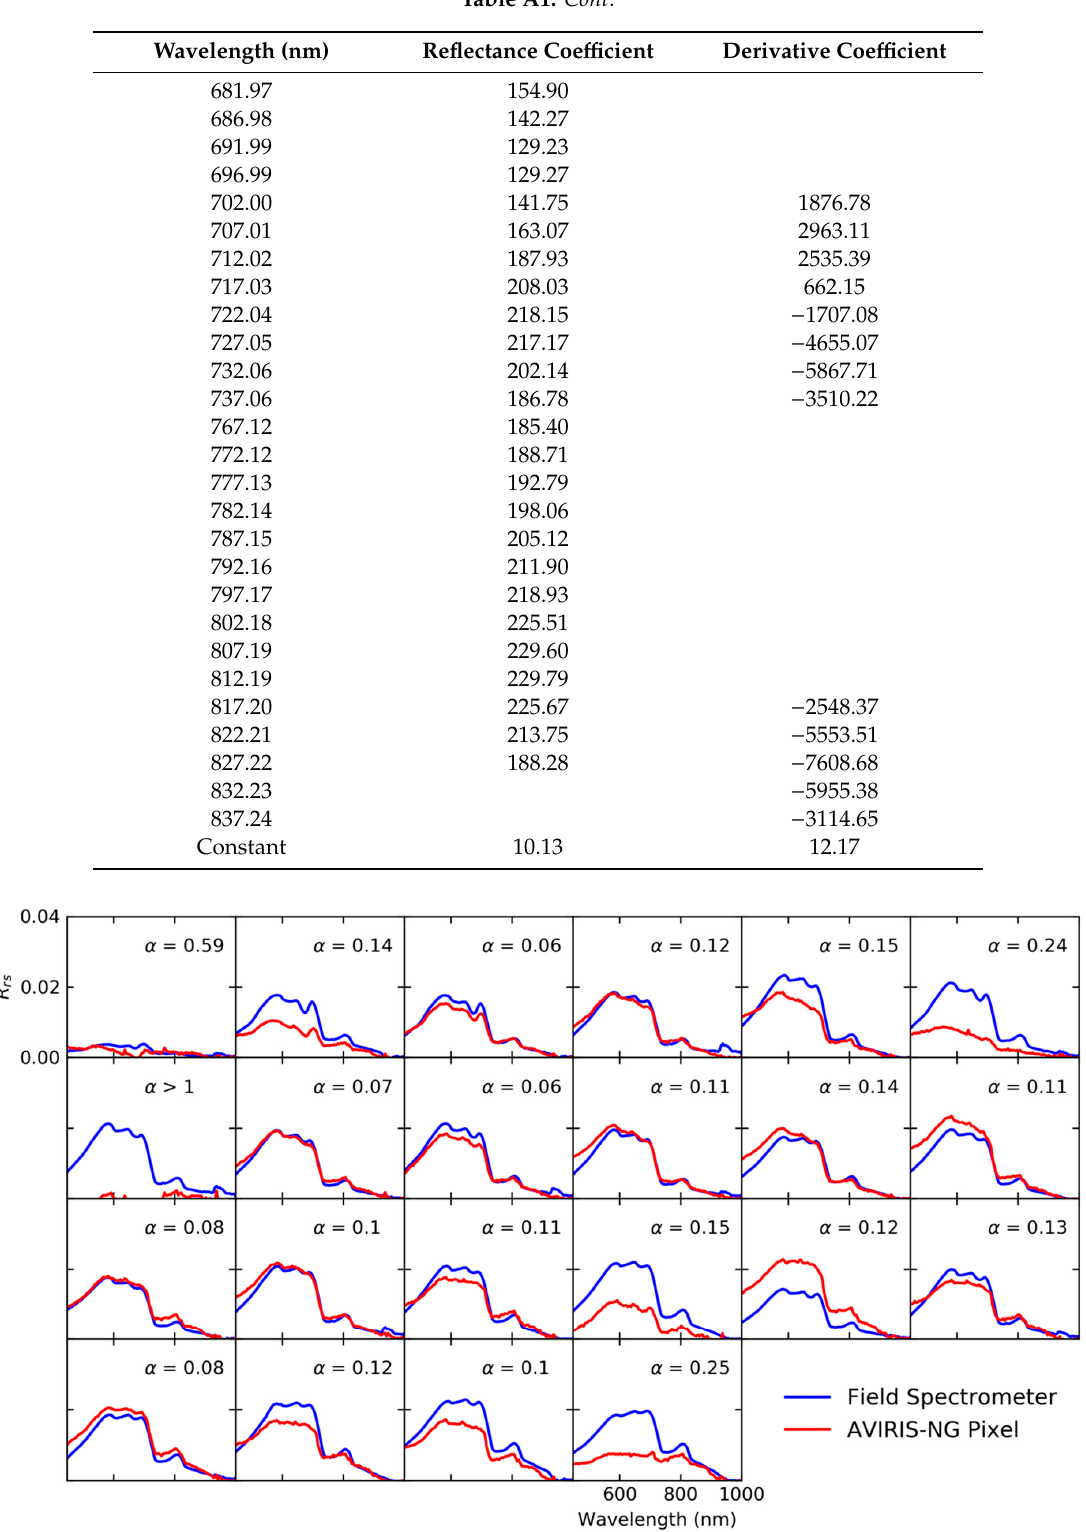
Figure A1. Remote sensing reflectance spectra derived from the ASD FieldSpec ® 3 spectrometer and the corresponding AVIRIS-NG pixel spectra, with all corrections applied. Spectral angle, represented by 𝛼 , is a measure of the difference in overall spectral shape between the two samples, with 0 denoting a perfect similarity.